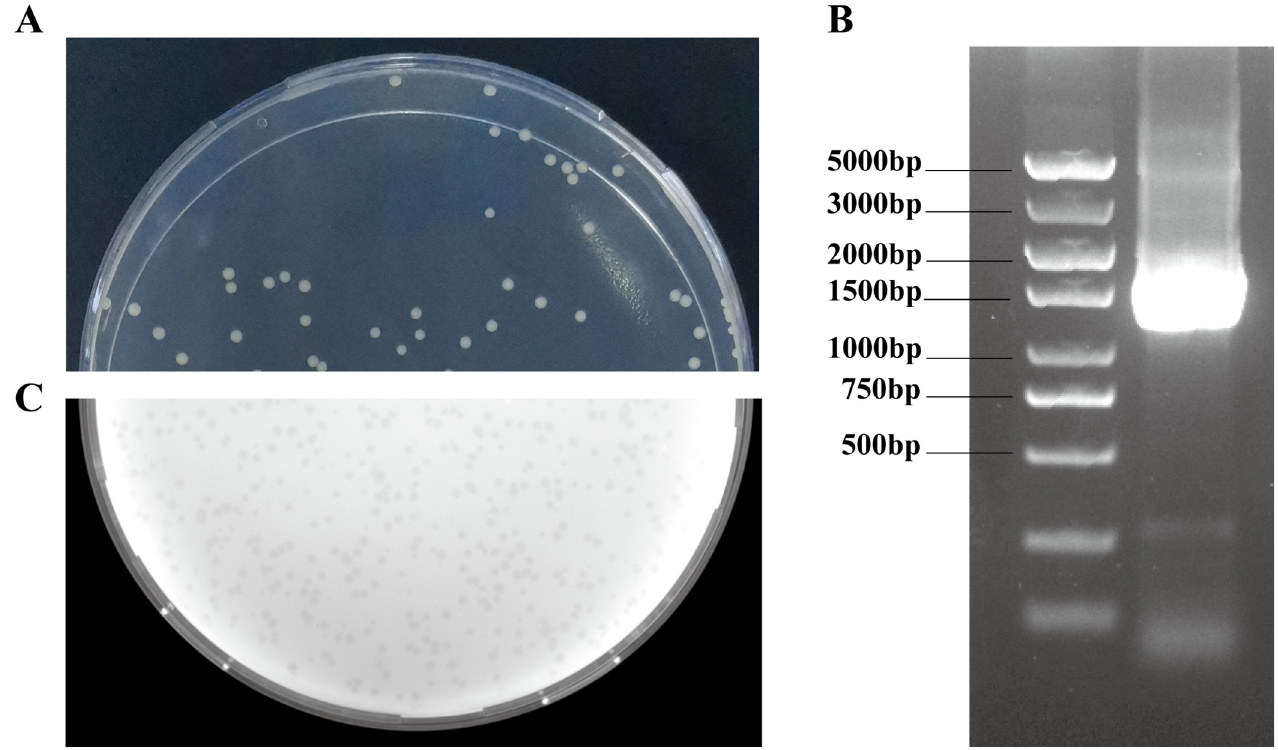
Fig 1. (A) The coated plate of V . parahaemolyticus 6A. (B) Gel electrophoresis result of16s PCR of V . parahaemolyticus 6A. (C) The formed plaques of phage vB_VpS_PG28 using Vibrio parahaemolyticus 6A as a host strain.